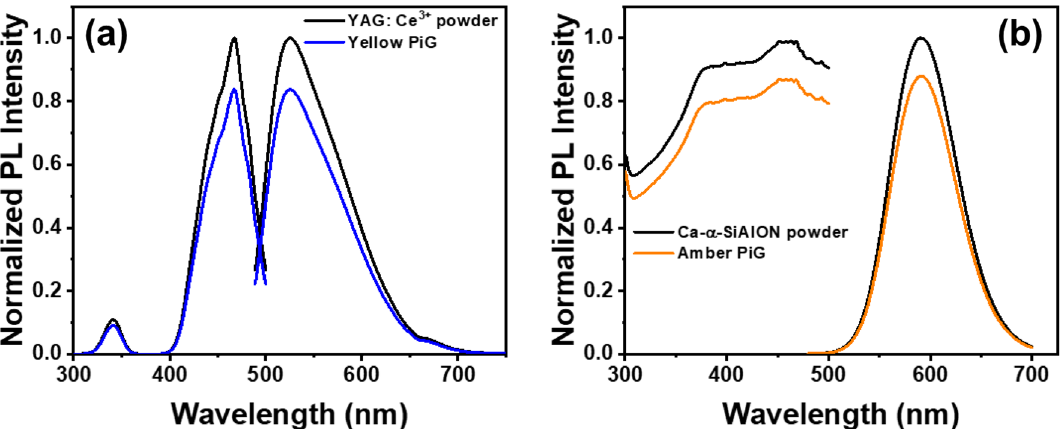
Figure 6. PL analysis of ( a ) YAG: Ce 3+ powder and yellow PiG and ( b ) Ca-α-SiAlON powder and amber PiG.